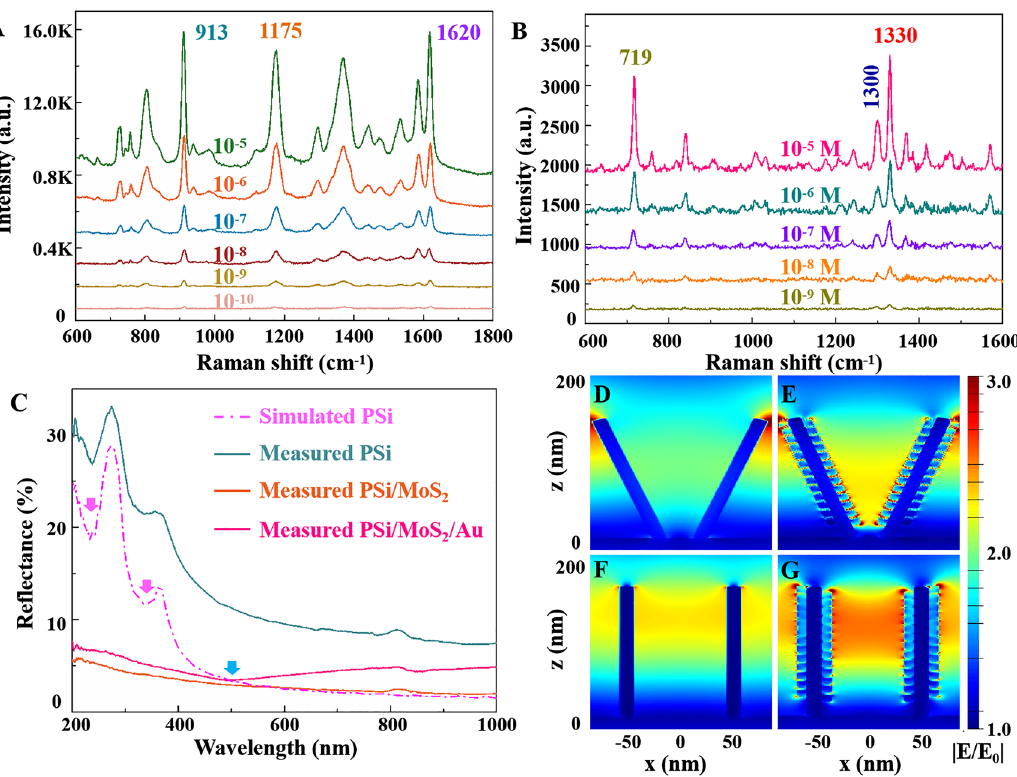
Figure 5: Surface-enhanced Raman spectroscopy (SERS) performance of crystal violet (CV) and electric field distribution. Raman spectra of (A) CV alcoholic solution (B) adenosine triphosphate on the pyramid Si (PSi)/ molybdenum disul fi de (MoS 2 )/Au multiscale cavity(MSC).(C)Re fl ectancespectrumofsimulatedPSi,measuredPSi,PSi/MoS 2 MSC,andPSi/MoS 2 /AuMSC.Simulatedverticalelectric fi eld distribution of (D) banked MoS 2 cavity, (E) banked MoS 2 /Au cavity, (F) vertical MoS 2 cavity, and (G) vertical MoS 2 /Au